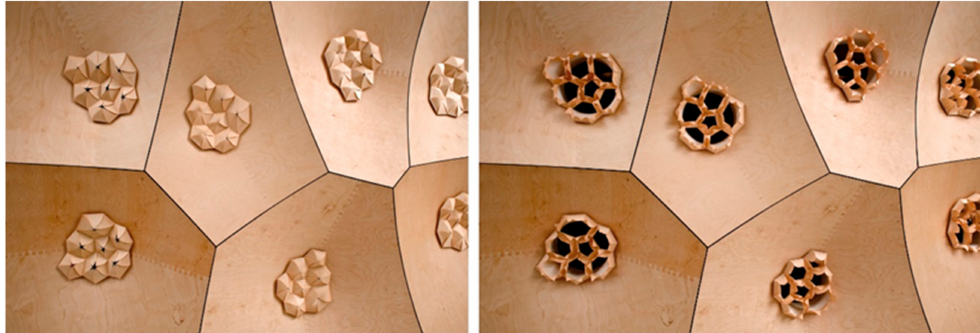
Figure 2. HygroSkin-Meteorosensitive Pavilion, details (© ICD University of Stuttgart, © Achim